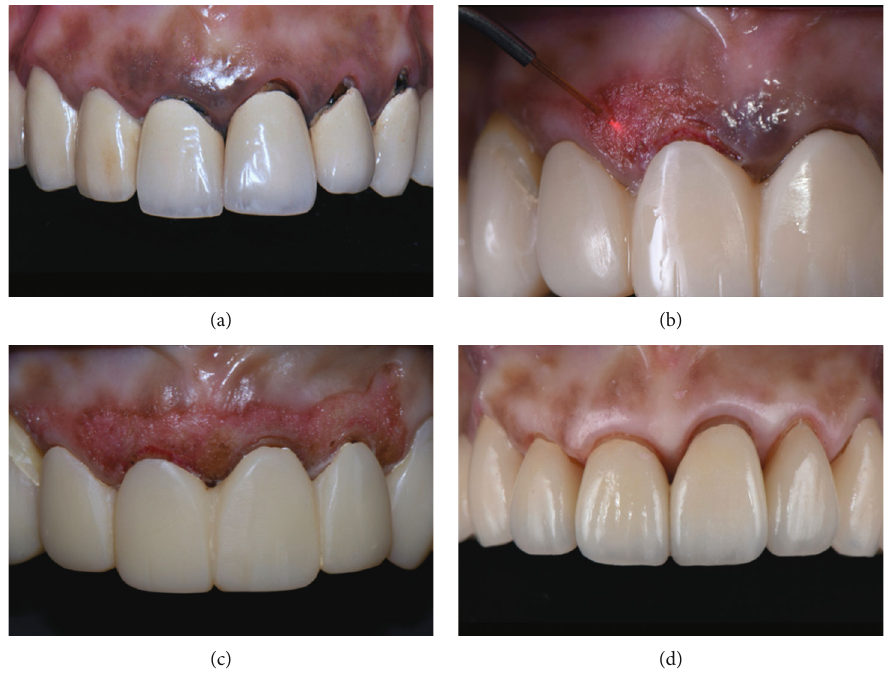
Figure 4: (a) Gingival pigmentation and discolored crown margins. (b) Gingivoplasty with a diode laser. (c) Immediate postoperative state of gingival peeling. (d) One-year recall showing minimal redeposition of melanin and minimal gingival